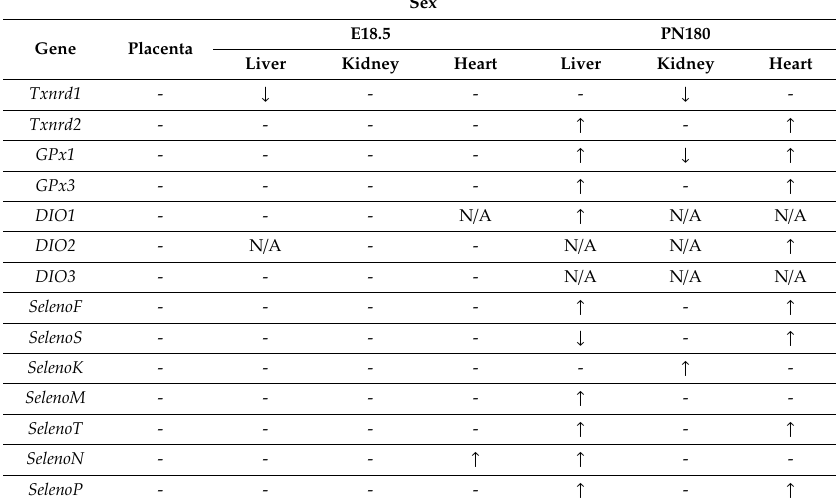
Table 2. Summary table of the e ff ects of sex on selenoprotein expression in various foetal and o ff spring